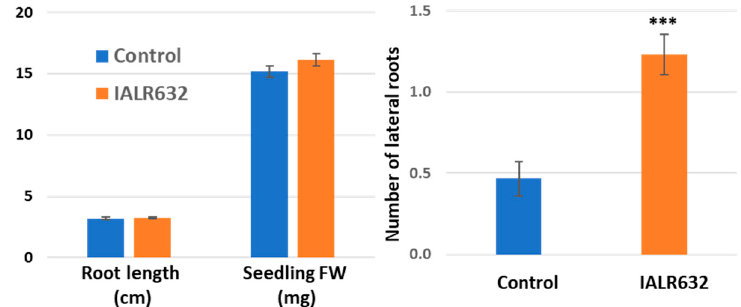
Figure 1. Effect of IALR632 inoculation on seedling growth and lateral root development. *** on the column means statistically significant difference at p < 0.001.